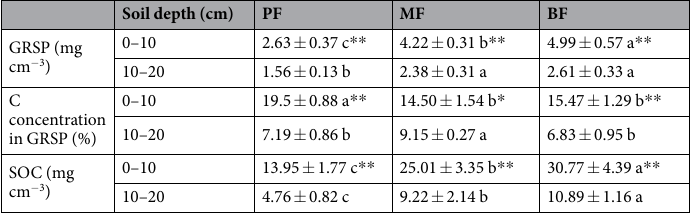
Table 1. Concentrations of GRSP and SOC in the tropical forests of the DBR, southern China. Mean values derived from 7 replications are presented with standard deviations. Different lowercase letters indicate significant differences ( P < 0.05) among the forests (a, b, c in rows) and * or ** indicates significant differences between 0–10 cm and 10–20 cm soils at the P = 0.05 or P = 0.01 level, respectively. Abbreviations: BF, the primary monsoon evergreen broadleaf forest; MF, the secondary mixed pine and broadleaf forest; PF, the planted pine